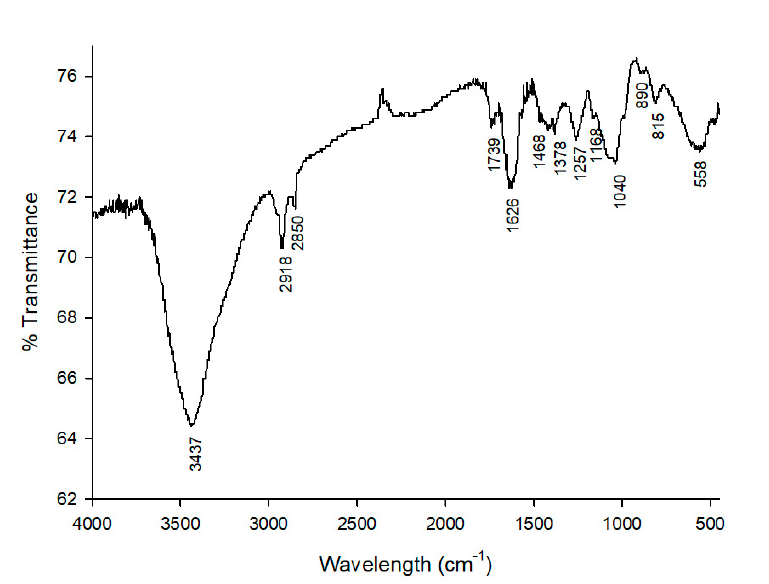
Figure 1. FT-IR spectra of the sulfated polysaccharides (